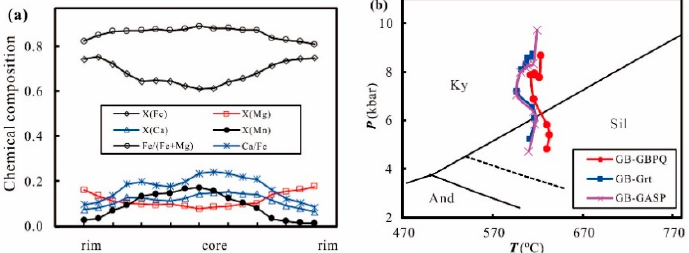
Figure 5. Chemical composition of the zoned garnet ( a ) and application of the garnet-biotite geothermometer [55] in concert with different geobarometers to the inclusion assemblages ( b ). Data were taken from [73] as listed in Table S3. Al 2 SiO 5 phase diagram: the sold lines are from reference [65], whereas the dashed line is from [66].